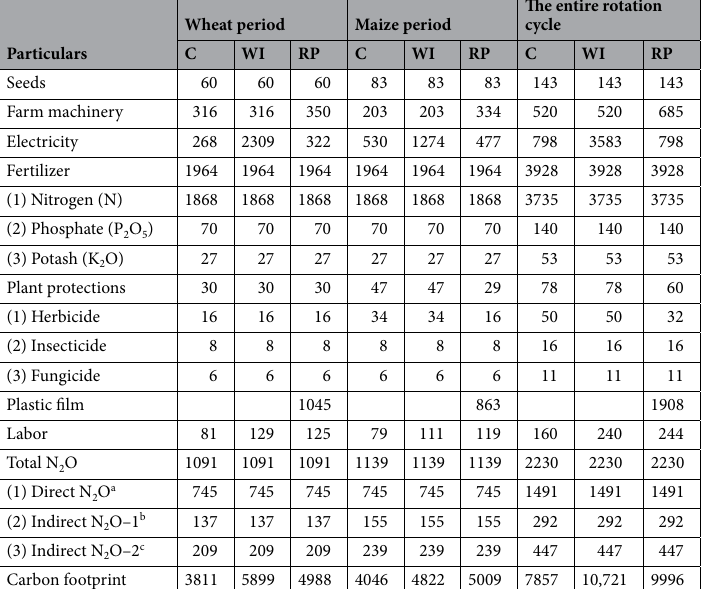
c Indirect N 2 O–2, indirect